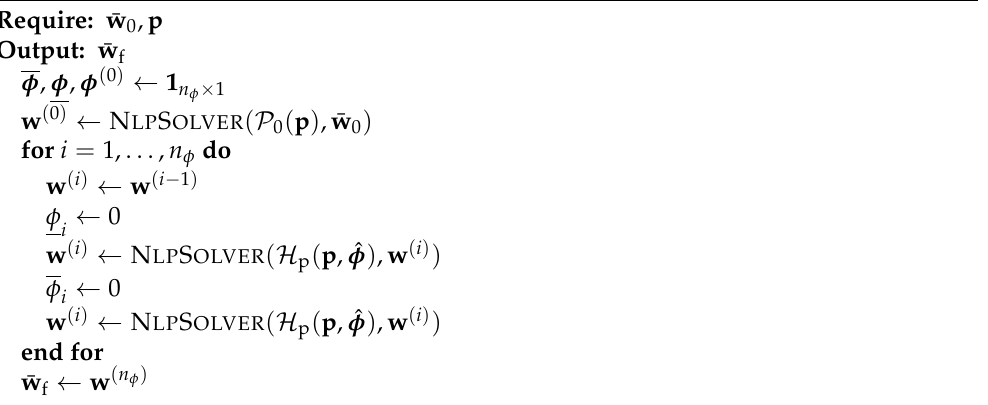
Algorithm 2 Penalty-based Interior-Point-based Homotopy